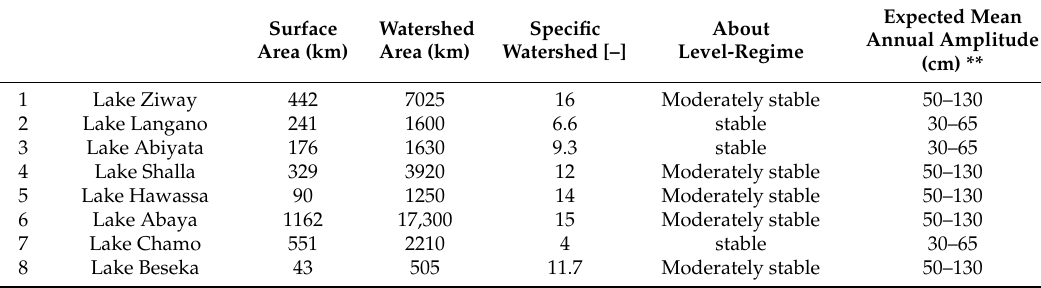
Table 4. Results of characterization based on specific watershed.